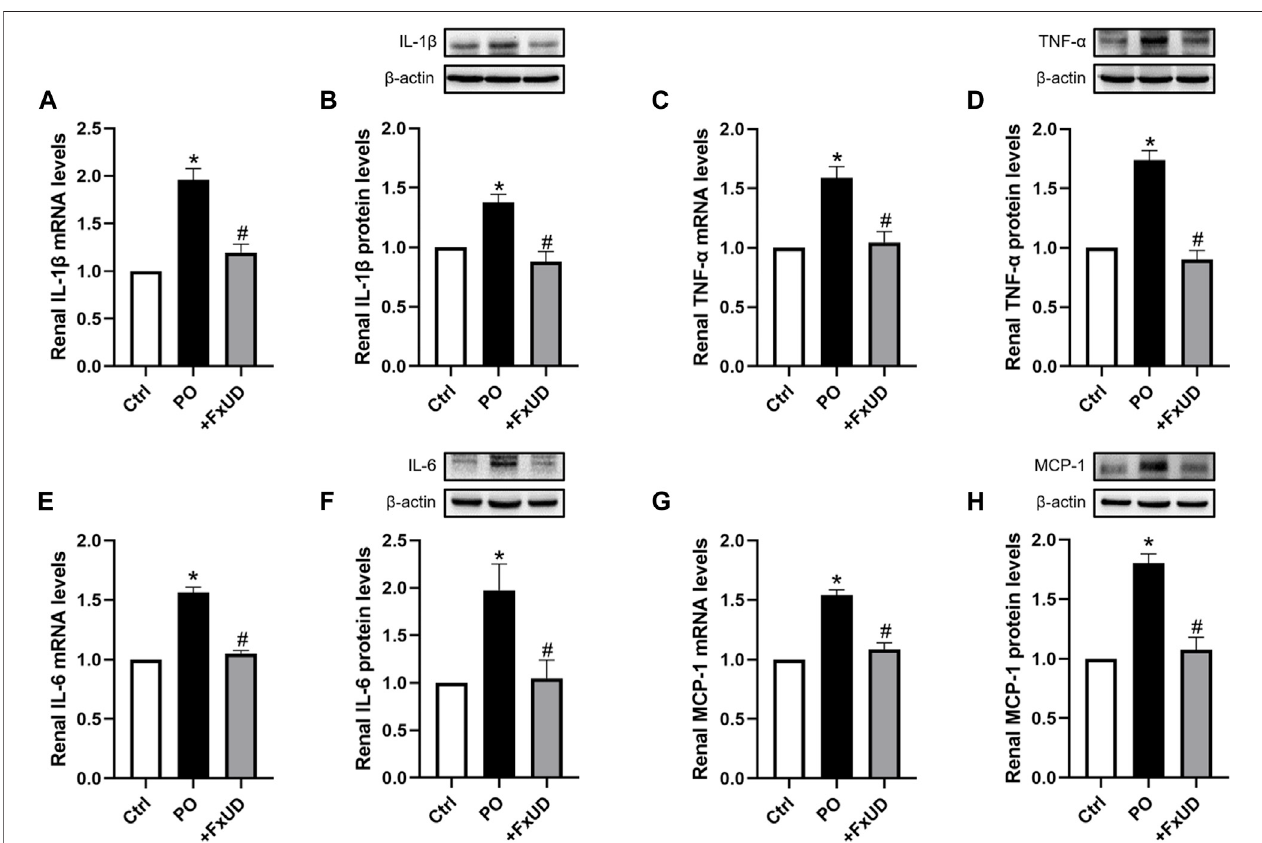
FIGURE 4| FxUD decreases the expression ofrenal in fl ammatory cytokines in hyperuricemic mice. (A) qRT-PCR assay and (B) Western blot analysisof IL-1 β . (C) qRT-PCRand (D) WesternblotresultsofTNF- α . (E) qRT-PCRand (F) WesternblotresultsofIL-6. (G) MCP-1mRNAand (H) proteinexpressioninthekidney.Valuesare expressed as the means ± SD ( n (cid:1) 4 – 5). * p < 0.05 vs. Ctrl, # p < 0.05 vs.